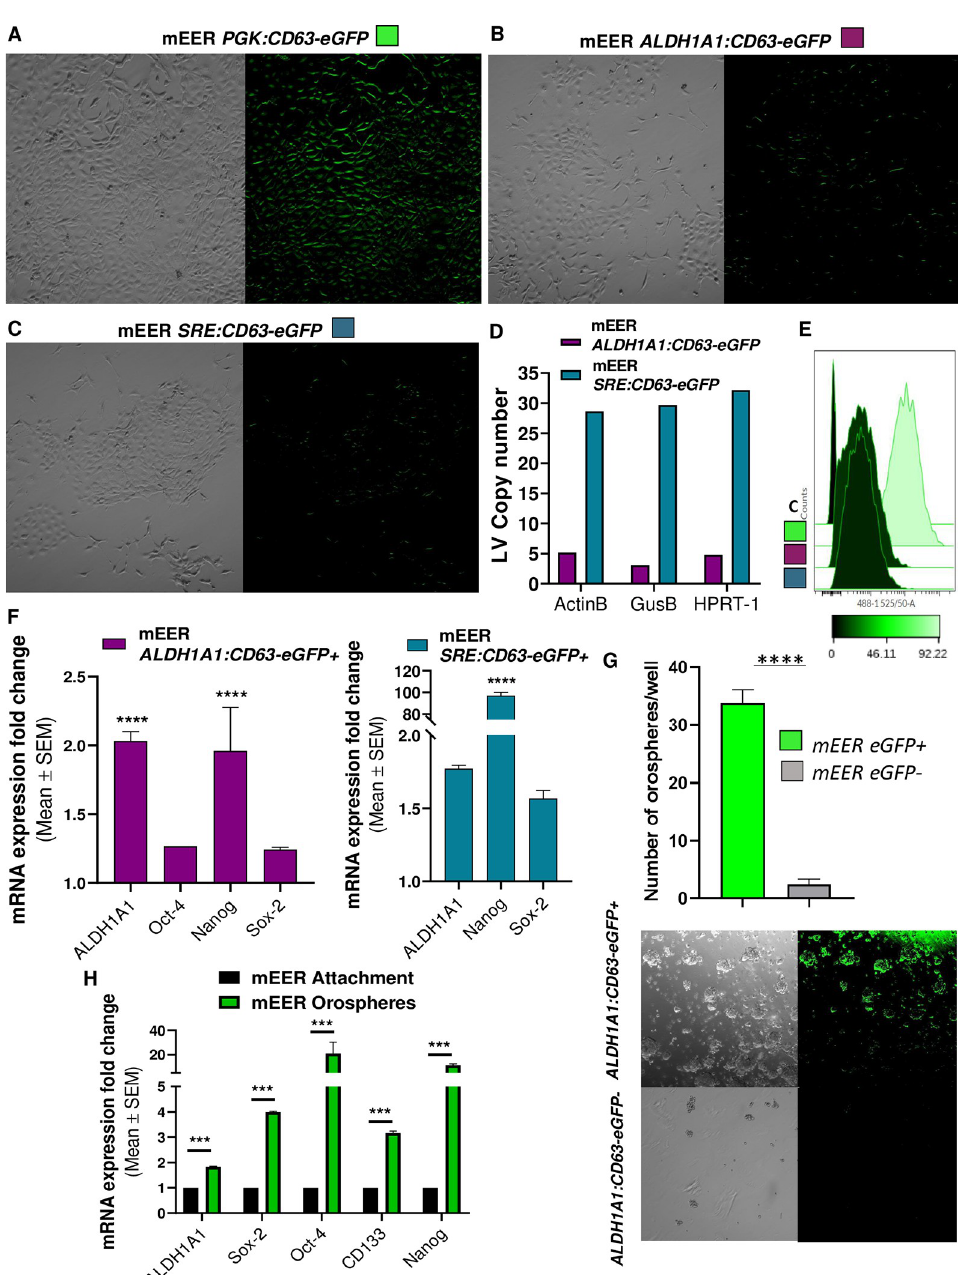
Fig 1. OSCC mEER CSC model characterization. (A) Representative fluorescence confocal microscopy images of in vitro cultured mEER cells stably transduced with PGK : CD63-eGFP reporter. Green cells represent the total tumor cells. (B, C) Representative fluorescence confocal microscopy images of cultured mEER cells carrying the ALDH1A1 : CD63-eGFP or the SRE : CD63-eGFP expression cassettes. Green cells represent the CSC population. (D) Graph representing the LV copy number present in genetically modified ALDH1A1 : CD63-eGFP and SRE : CD63-eGFP mEER cells assessed by PCR analysis. (E) Flow cytometry analysis displaying eGFP fluorescence in unmodified (Control, C) and genetically modified PGK : CD63-eGFP (green), ALDH1A1 : CD63-eGFP (purple) and SRE : CD63-eGFP (teal) mEER cells. (F) Relative increase in stemness gene expression of flow sorted brightest mEER eGFP + cells compared to eGFP- cell population analyzed by RT-qPCR. (G) Graph depicting the number of orospheres per well generated from flow sorted brightest mEER eGFP + cells versus eGFP- cells. Representative microscopy images of orospheres growing from flow sorted ALDH1A1 : CD63-eGFP + mEER and ALDH1A1 : CD63-eGFP- mEER cells cultured in 3D tumorsphere- specific medium are displayed. Green fluorescence indicates the high content of CSC in the orospheres. (H) RT-qPCR analysis showing the stemness gene expression signature of mEER orospheres enriched in ALDH1A1:CD63-eGFP